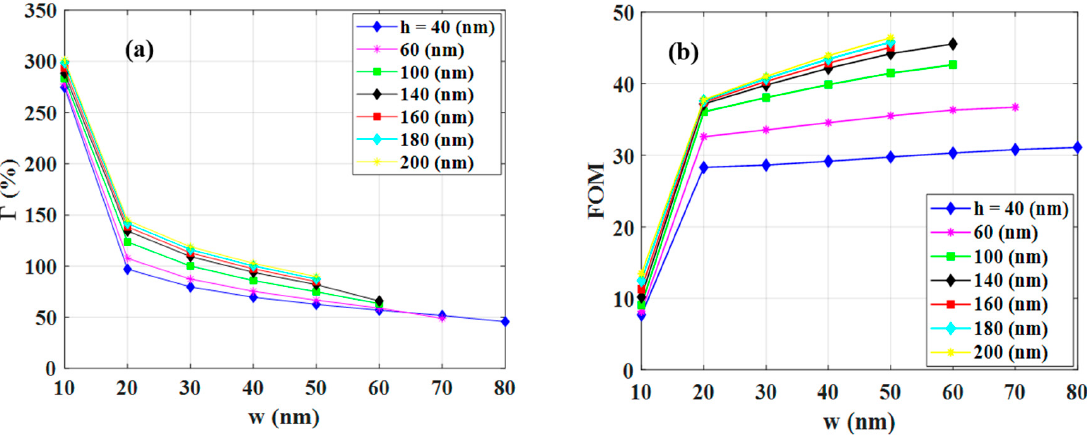
Figure 8. ( a ) The confinement factor Γ and ( b ) the FOM for the plasmonic slot waveguide as a function of slot width w for different slot heights.